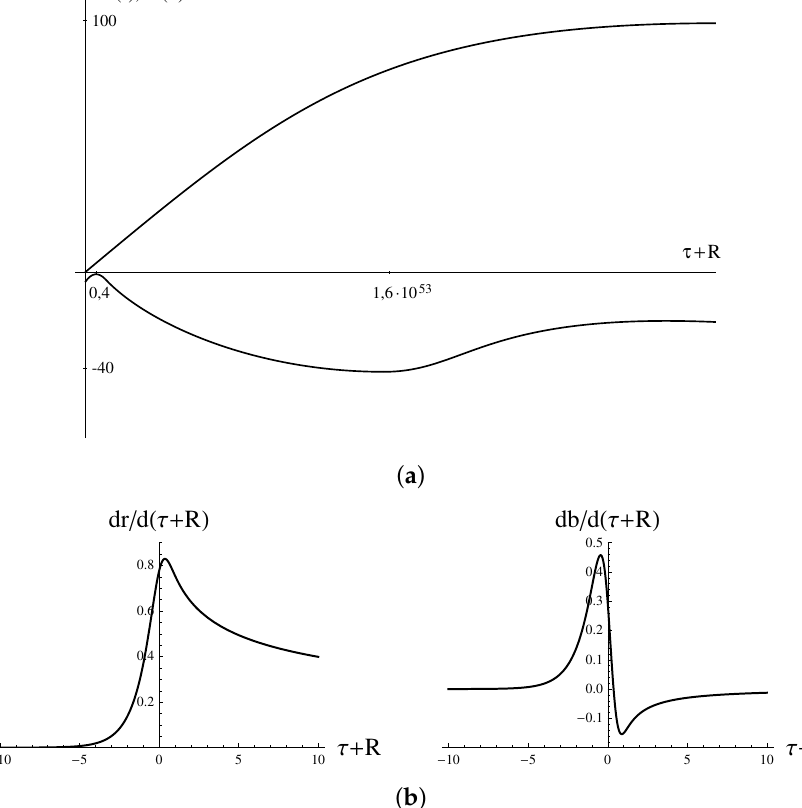
Figure 4. Behavior of the scale factors ( a ), and their derivatives dr / d τ , db / d τ ( b